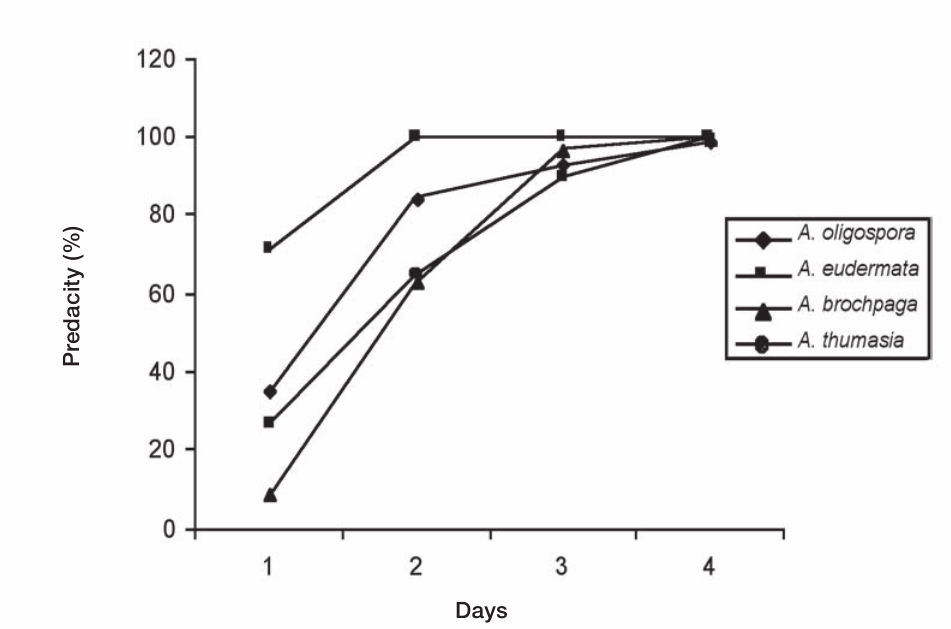
Fig 2. Comparison of trapping effectiveness (%) of four species of Arthrobotrys nematophagous fungi on specimens of Panagrellus redivius added to each Petri